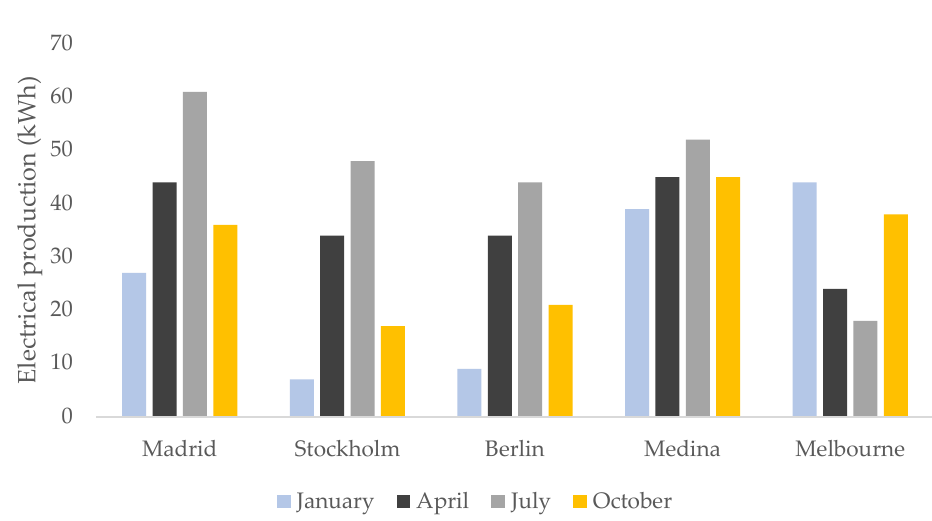
Figure 12. Collector monthly thermal production variation.